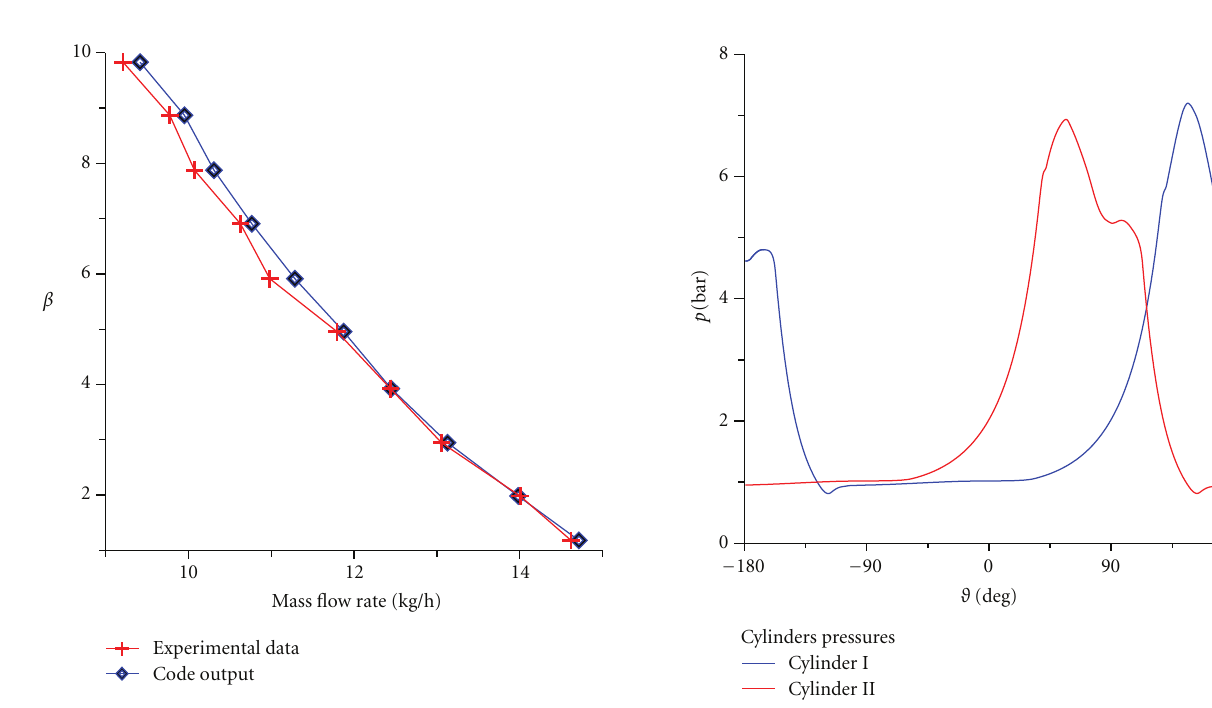
Figure 6: Pressure in the cylinders at β =